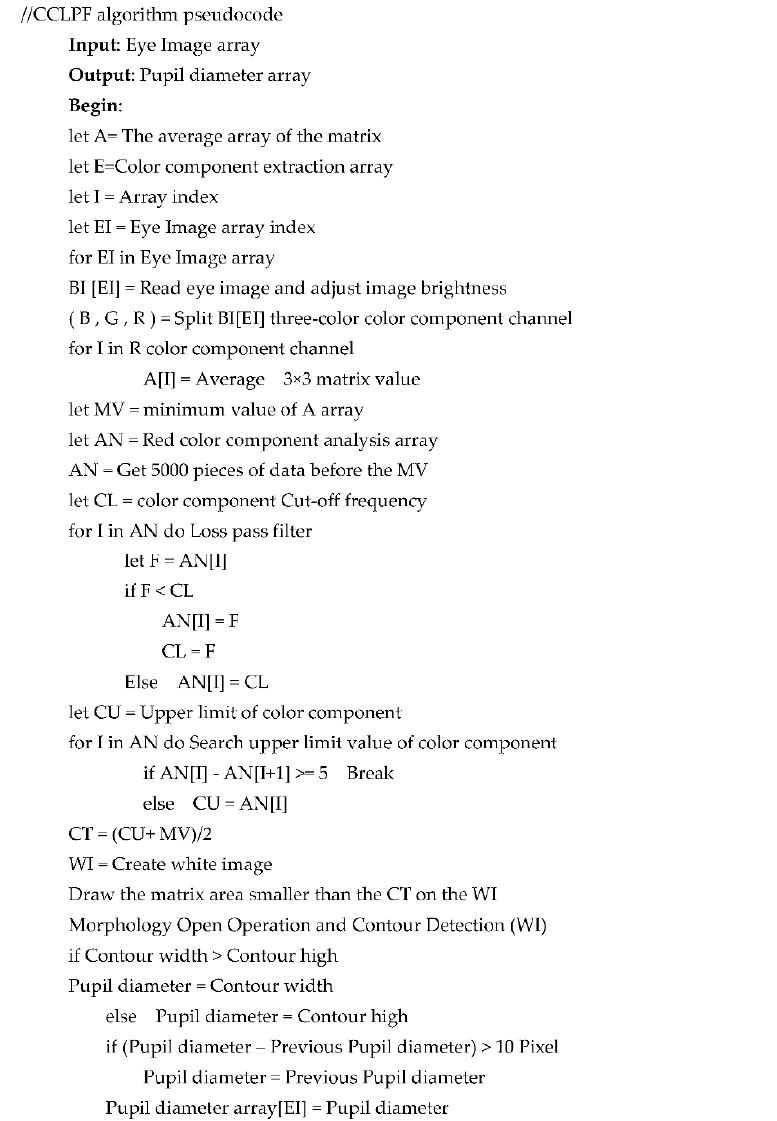
Figure 32. Pseudocode of the CCLPF algorithm.